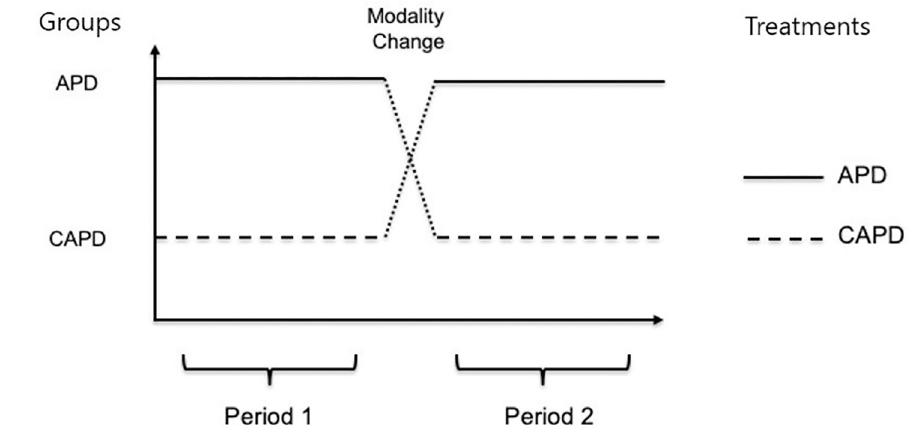
Fig 1. Study design. Periods 1 was 3 months before the modality change. Period 2 was 3 months after the modality change. Patients without sufficient laboratory data (less than 2 measurements) in both the before and after time periods were excluded from the